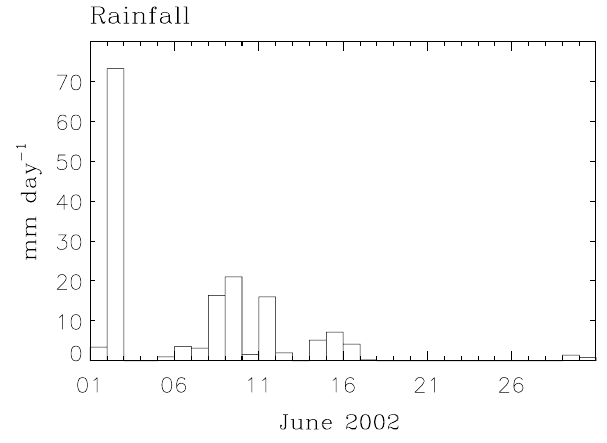
Fig. 9. Daily rainfall amount observed at Kototabang GAW station in June 2002.